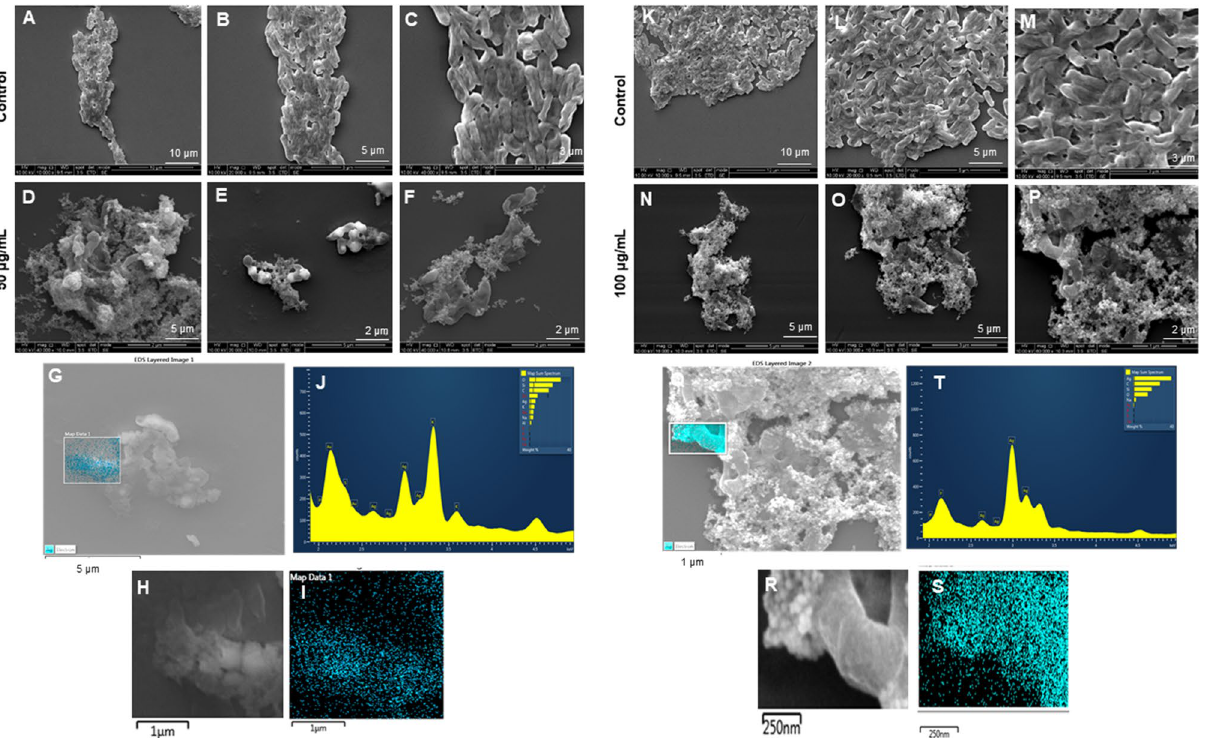
Figure 10. SEM analysis of P. aeruginosa cells after treatment with LV-AgNPs. (A-F) Control cells and LV-AgNPs treated cells with 50 μg/ml at different scales. (G) Scanned image of treated cells (H,I) elemental mapping of the selected area showing silver element in the treated cells, (J) EDX spectrum of the chosen area showing peak for silver element. (K-P) Control cells and LV-AgNPs treated cells with 100 μg/ml at different scales. (Q) Scanned image of treated cells (R,S) elemental mapping of the selected area showing silver element in the treated cells, (T) EDX spectrum of the chosen area showing peak for silver